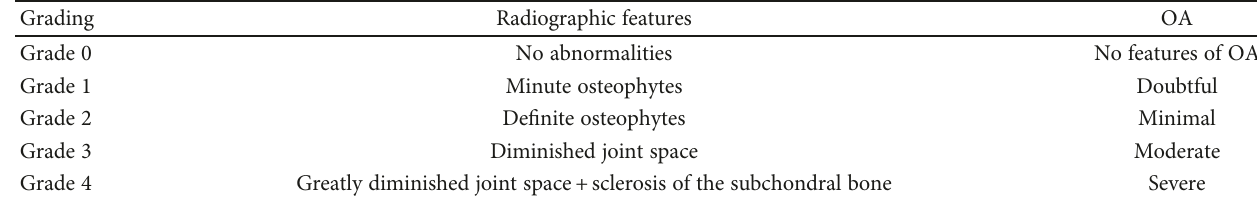
Table 1: The Kellgren-Lawrence grading of osteoarthritis ∗